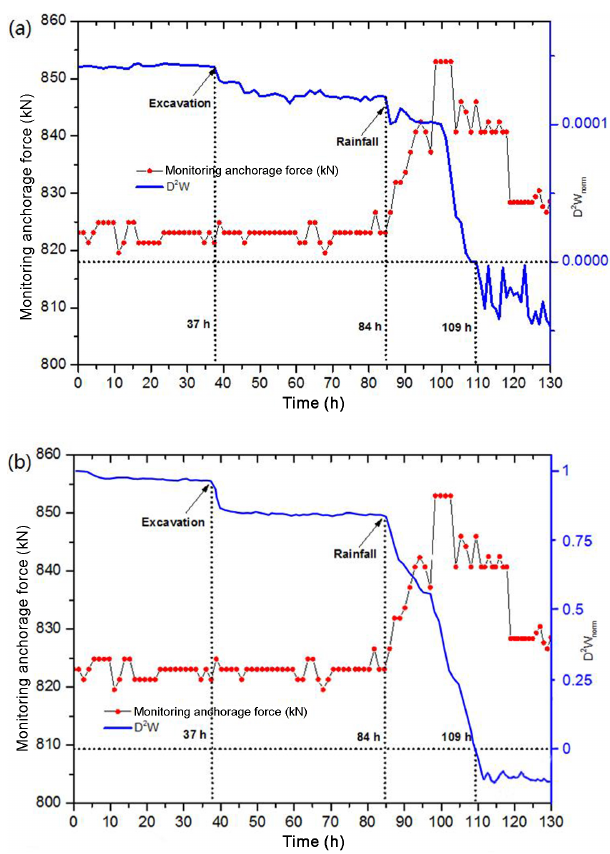
Figure 16. Evolution of monitoring anchorage force and normal- ized global second-order work, computed according to (a) Eq. (10) and (b) Eq.